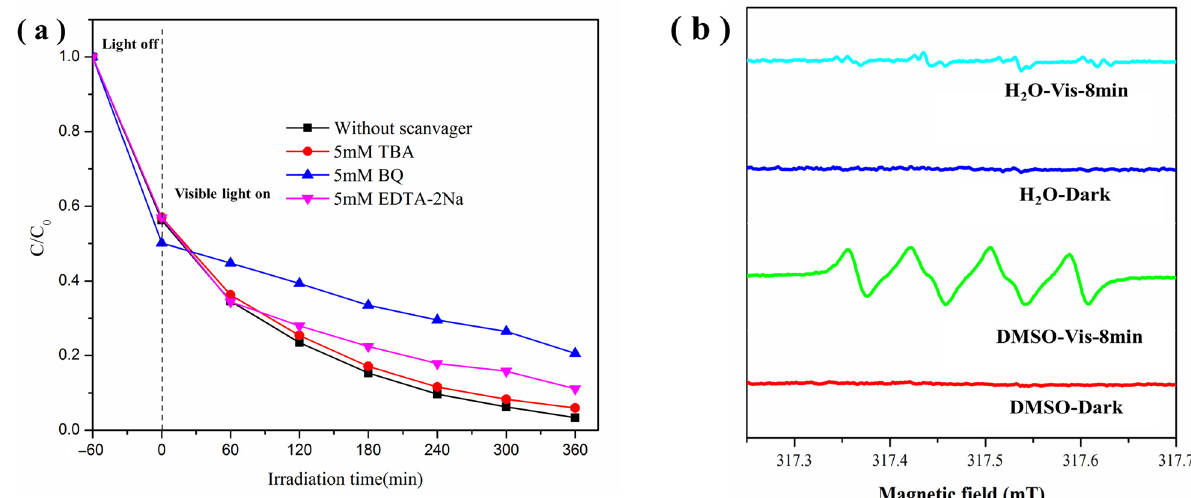
Figure 10. The plots of photogenerated carriers trapping on the photodegradation of RhB under visible light in the presence of the Di/Ur-4:5 composite ( a ), and ESR spectra of the Di/Ur-4:5 compo- site in DMSO solvents and water ( b ), with